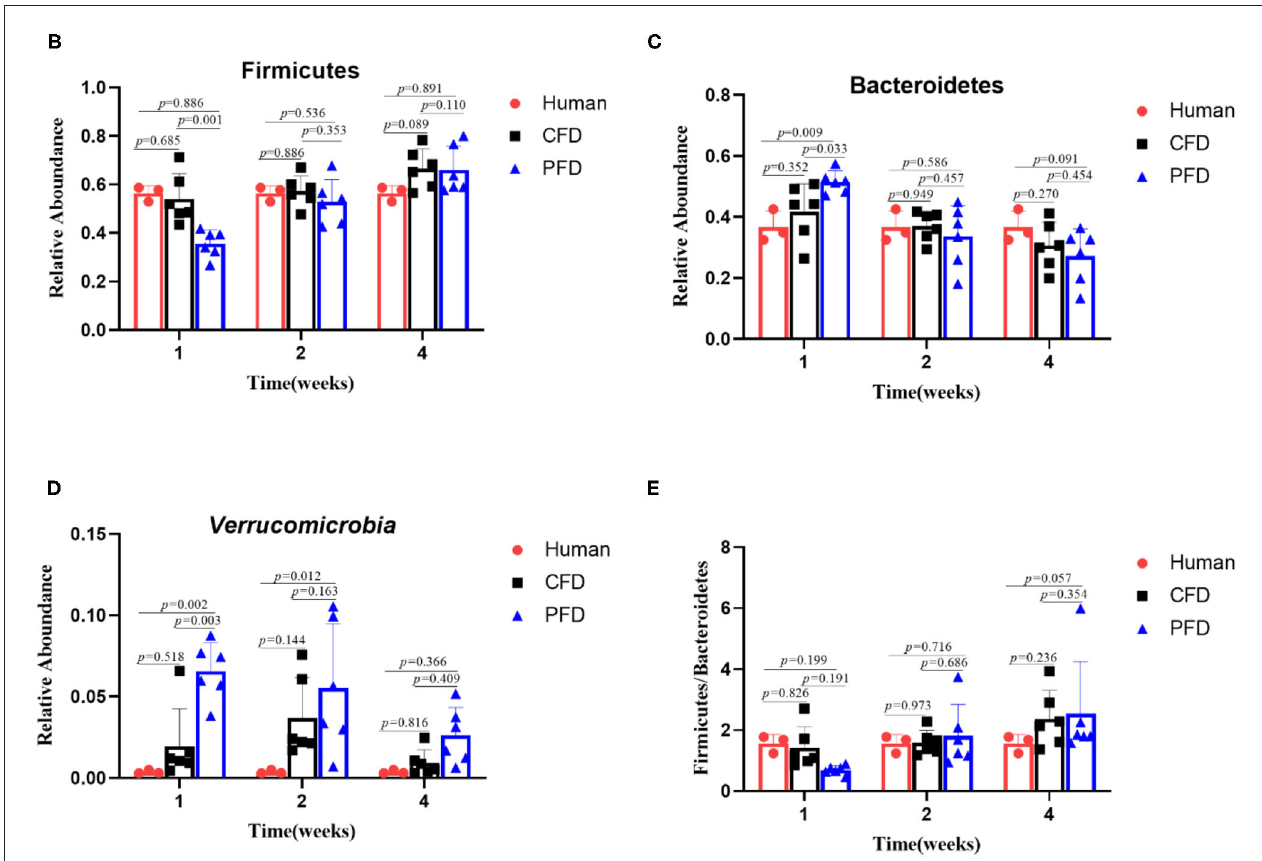
FIGURE 4 | Relative abundance of gut microbiota. Relative abundance for (B) Firmicutes, (C) Bacteroidetes, (D) Verrucomicrobia, (E) Ratio of Firmicutes to Bacteroidetes.